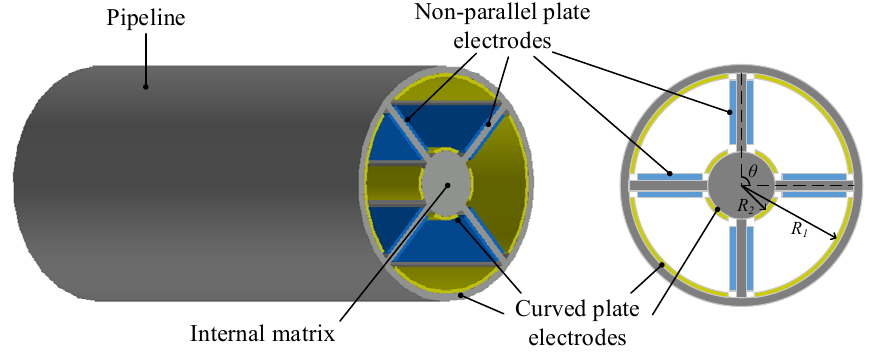
Figure 2. Schematic diagram of coaxial capacitance sensing network model.